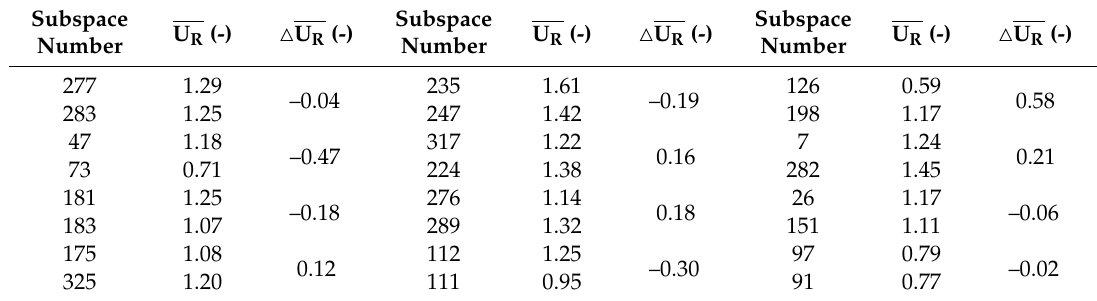
Table 7. Calculation of the value of the mean wind velocity ratio’s (U R ) di ff erence between the 12 pairs of subspaces.